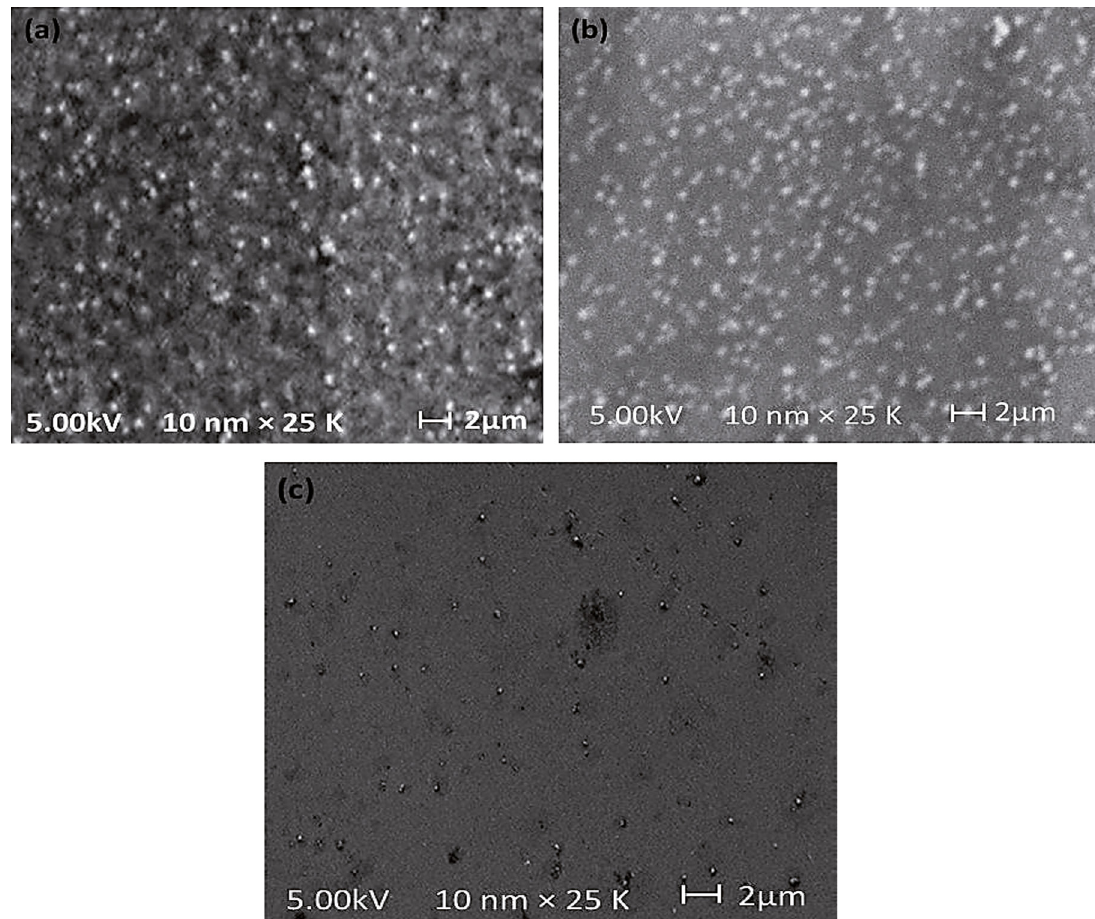
O film with different thicknesses. 2 3